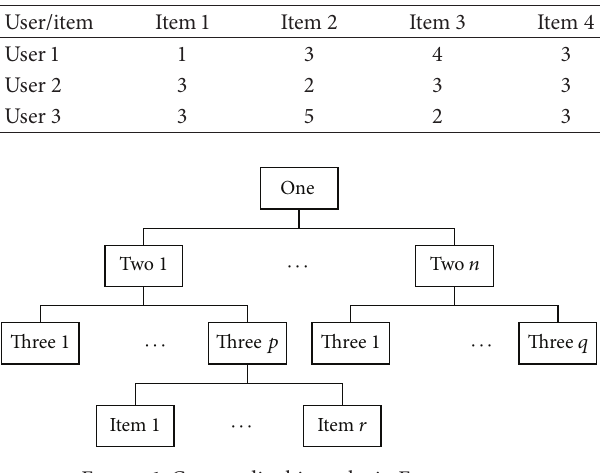
Figure 1: Commodity hierarchy in